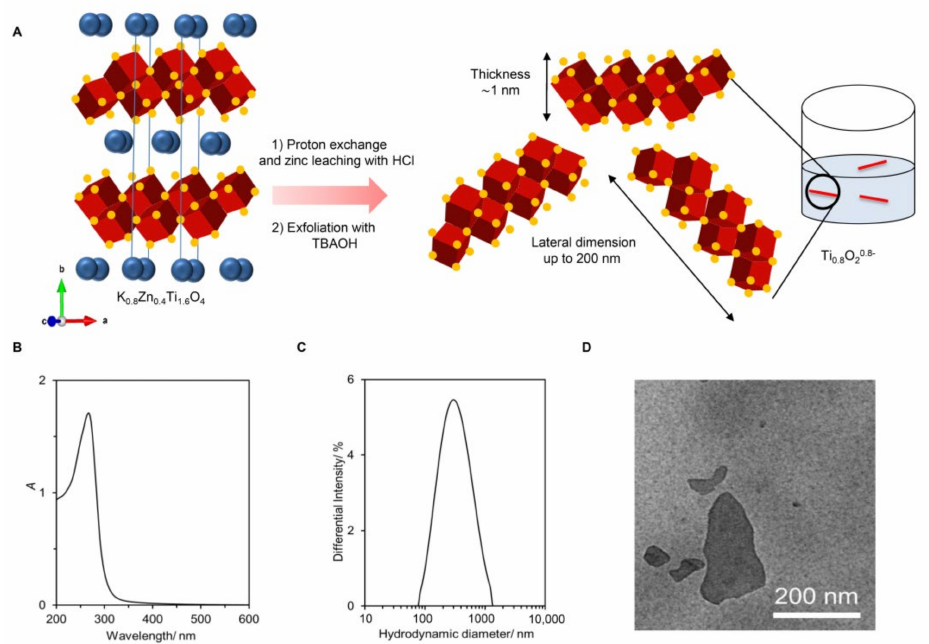
Figure 1. Synthesis and characterization of the Ti 0.8 O 2 nanosheets. ( A ) The schematic diagram of Ti 0.8 O 2 nanosheet preparation. The crystal structure of K 0.8 Zn 0.4 Ti 1.6 O 4 shows K + ions (green) sandwiched between the double edge-shared O atoms in red and Ti atoms at the center in blue; ( B ) UV- vis absorption spectrum and photograph of the nanosheets without and with the laser light shining through; ( C ) size of the nanosheets; ( D ) representative TEM image of the deposited